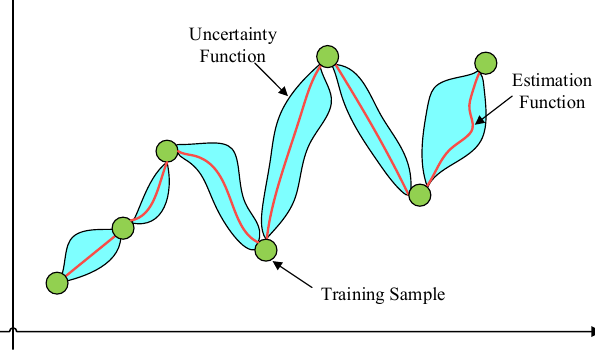
Figure 4. Gaussian processes specified by the estimation function and the uncertainty function.